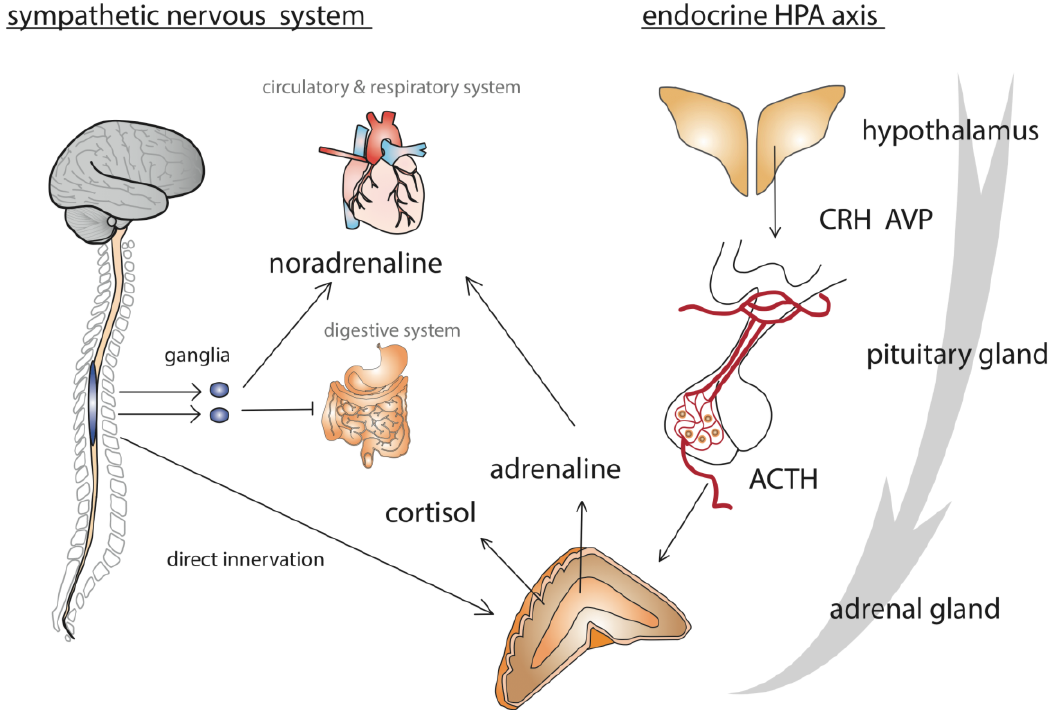
Figure 1. Human stress response pathways operating through the autonomic nervous system and the endocrine system. This diagram illustrates how neural and hormonal signals interact and complement each other through the regulatory action of the hypothalamo-pituitary-adrenal axis (HPA axis). ACTH: adreno-corticotropin hormone. AVP: arginin/vasopressin. CRH: cortico-releasing hormone. Adapted with permission from Macmillan Publishers Ltd.: Nature Reviews Neuroscience [25], copyright